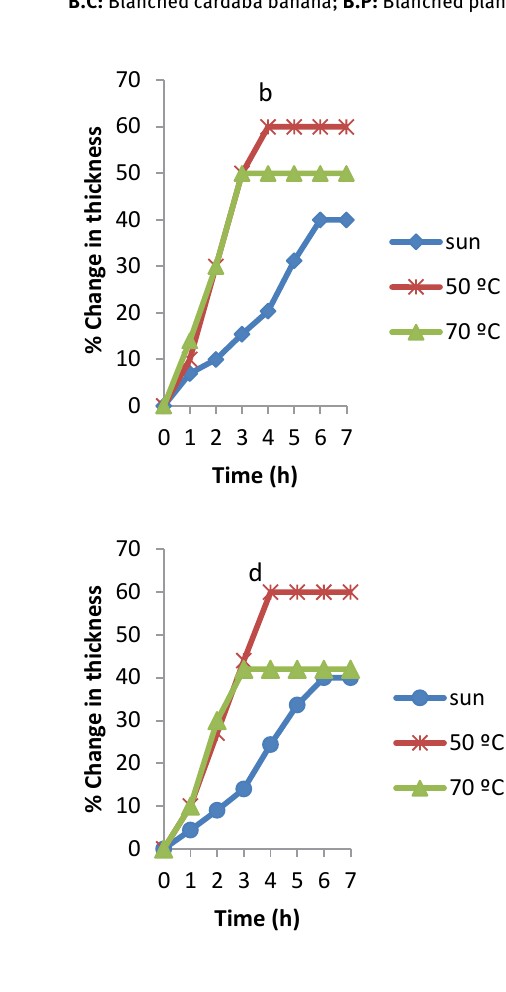
Figure 3: Percentage change in thickness for: Figure 4: Percentage change in thickness for: a) Unblanched cardaba banana slices; b) Blanched cardaba banana slices; c) Unblanched plantain slices; d) Blanched plantain slices a) Unblanched cardaba banana slices b) Blanched cardaba banana slices Unblanched plantain slices